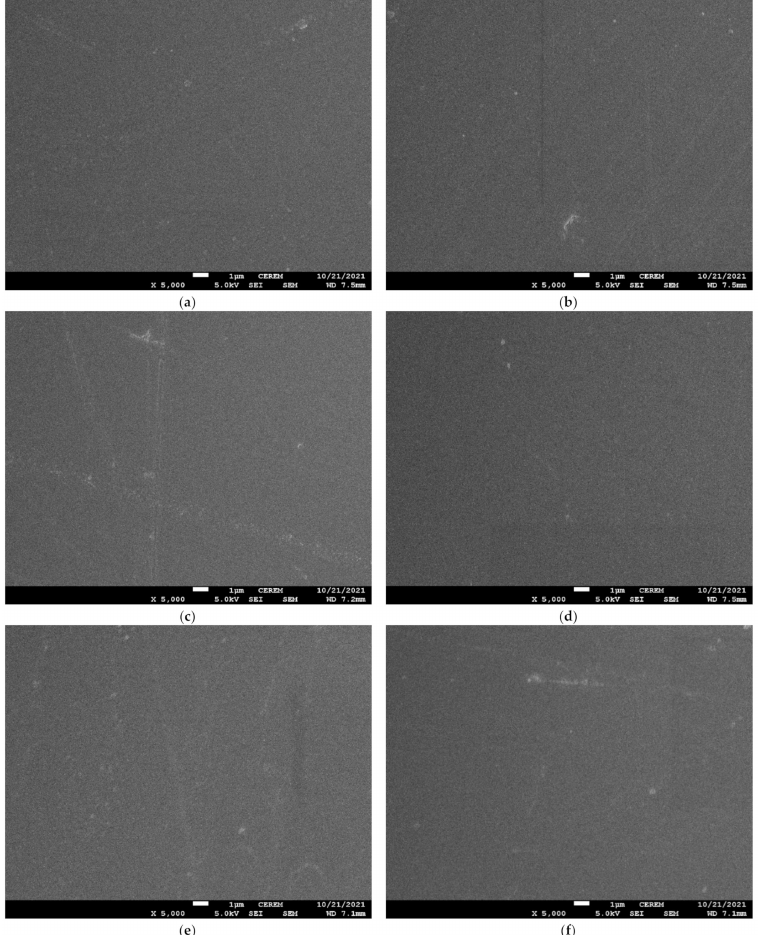
Figure 3. SEM images of prepared formulations with variation in hardener percentages. ( a ) E-0, ( b ) E-1, ( c ) E-2, ( d ) F-0, ( e ) F-1, ( f )